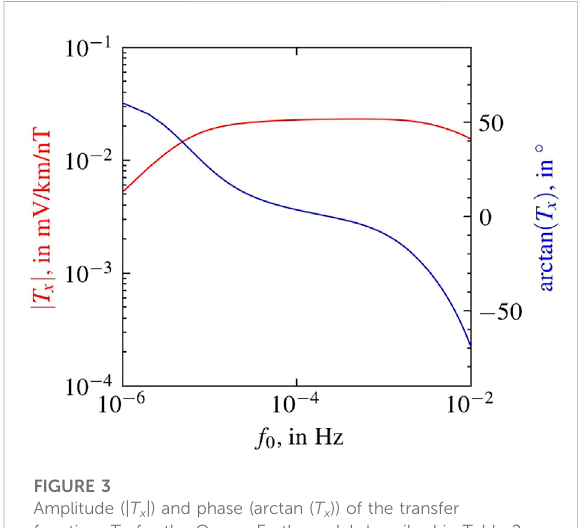
FIGURE 3 Amplitude (| T x |) and phase (arctan ( T x )) of the transfer function, T x , for the Ocean-Earth model described in Table 2. Example Python notebook for generating the transfer function is uploaded in Zenodo [21].